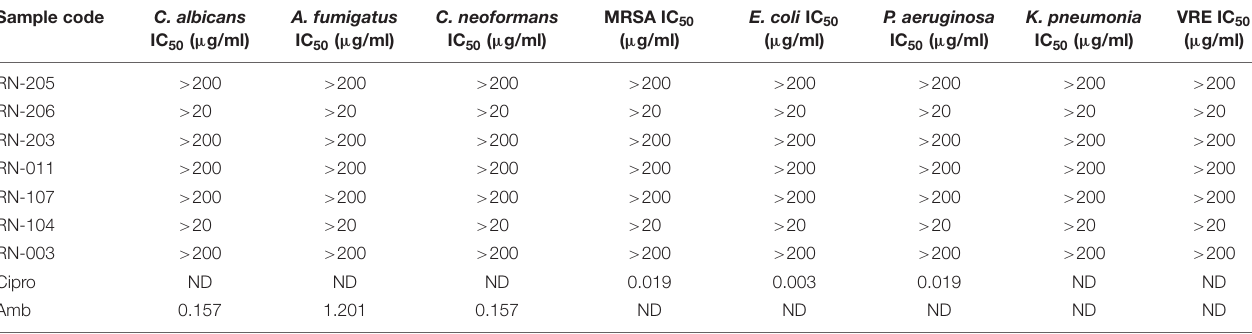
TABLE 3 | Antimicrobial screening of EtOAc extracts of selected isolates using CLSI method (OI). Sample